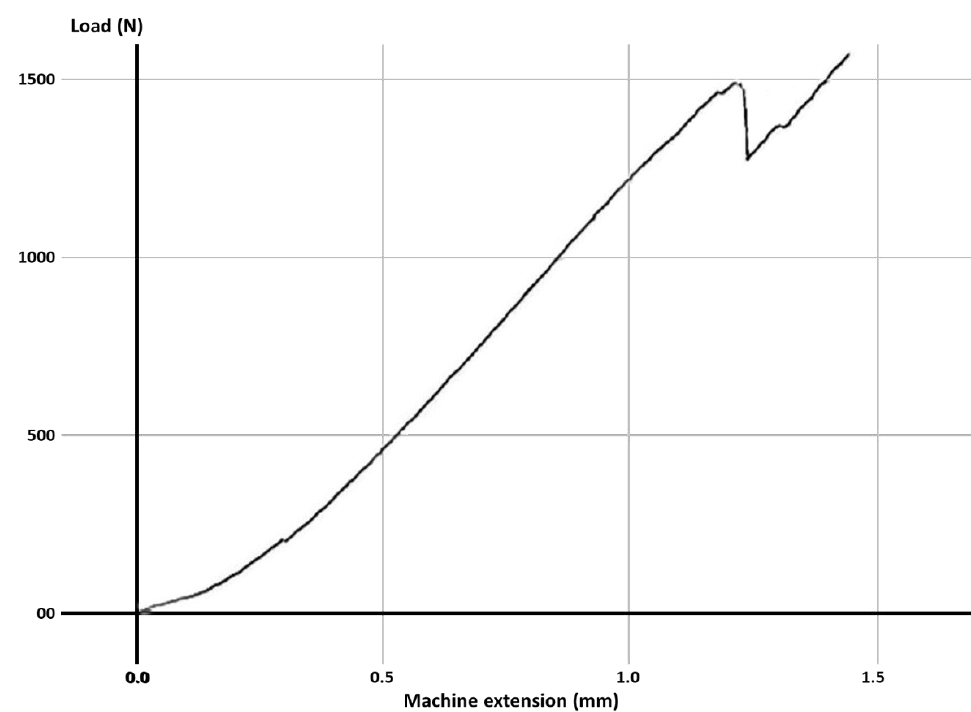
Figure 4. The maximum value of the force at which the most resistant molar from Group C failed.